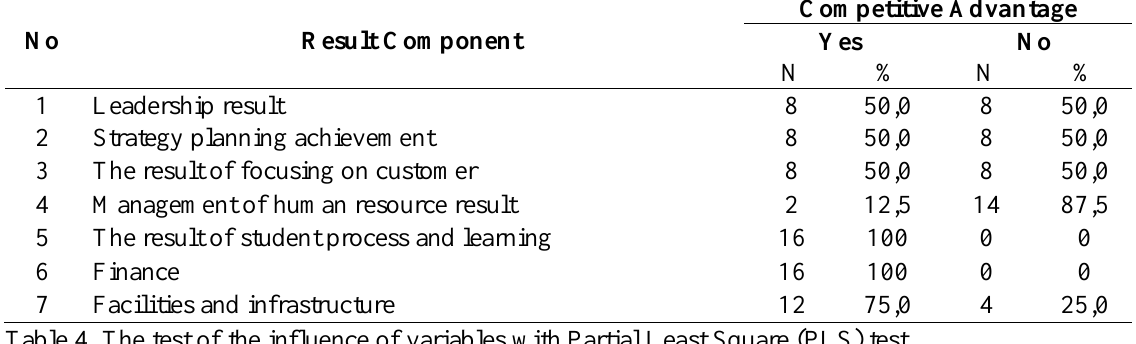
Table 3. The components of the quality results in nursing schools under Muhammadiyah universities